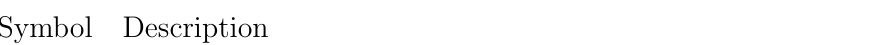
Table 2: Constitutive parameters used in Dieterich ’s relation.